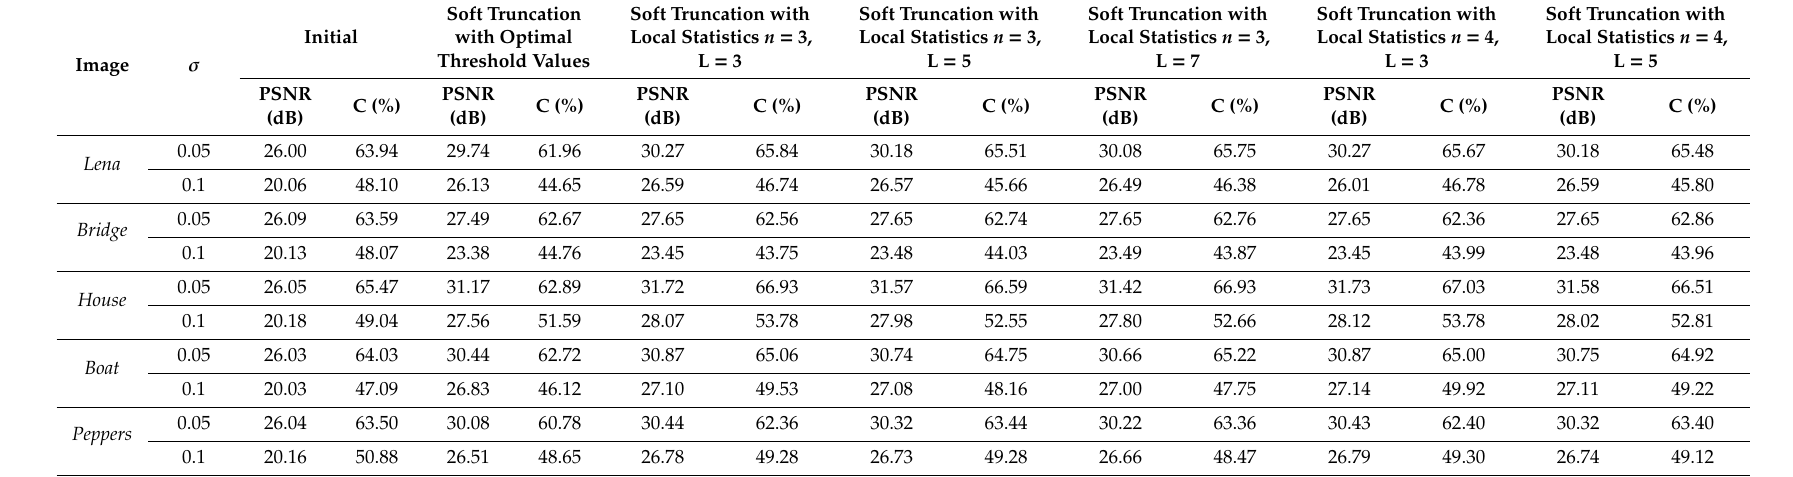
Table 3. Dependence of the results obtained in the first stage of the proposed algorithm, as a function of Table 2 ( L + 1). In all cases, better results are obtained when using local statistics compared to optimal threshold, for both PSNR and C (improvement of the